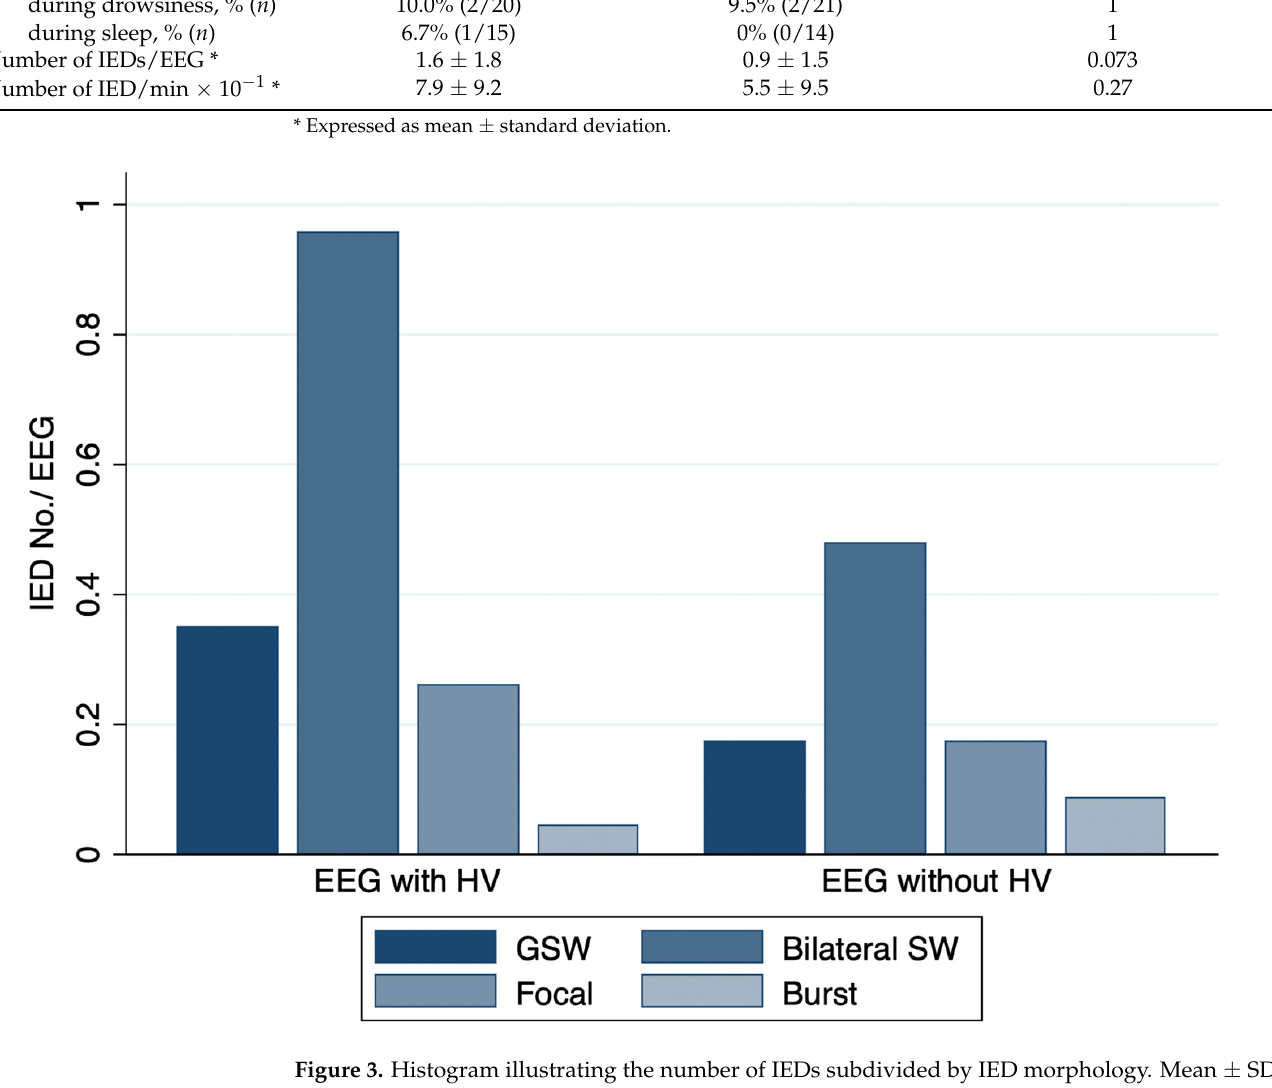
Figure 3. Histogram illustrating the number of IEDs subdivided by IED morphology. Mean ± SD number of GSW, bilateral SW, focal SW, and spike/sharp burst per EEG were 0.35 ± 0.78, 0.96 ± 1.43, 0.26 ± 0.62, and 0.09 ± 0.29 for EEG with HV and 0.17 ± 0.65, 0.48 ± 0.99, 0.17 ± 0.65, and 0.04 ± 0.21 for HV-free EEG, respectively. Mean number of IEDs/min limited to HV was 1.61 ± 2.25 × 10 − 1 . Mean number of IEDs/min limited to non-activation time was 0.57 ± 0.93 × 10 − 1 for the first EEG with HV and 0.39 ± 0.76 × 10 − 1 for the second EEG without HV (Figure 4). The mean number of IEDs/min when limited to HV was significantly larger than that limited to non-activation, at both first and second EEGs ( p = 0.039 and 0.009,